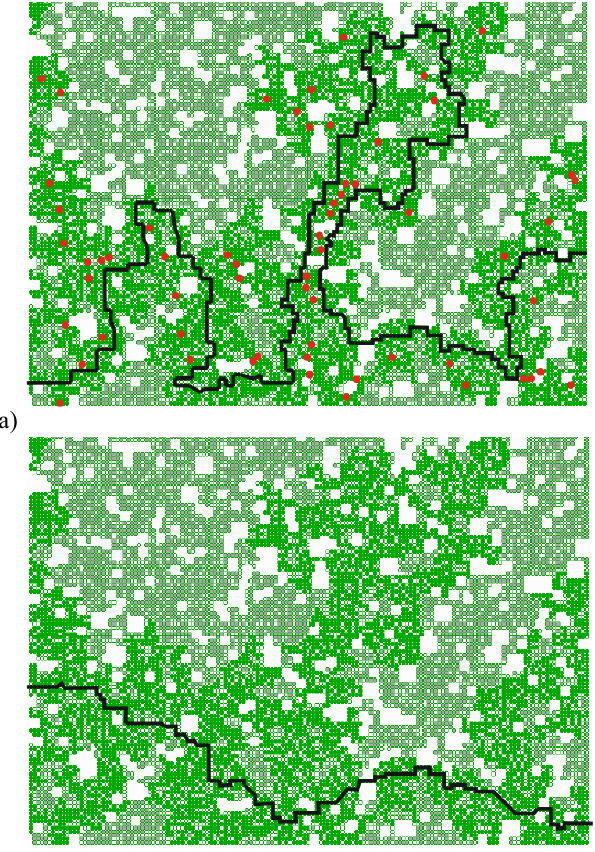
Figure 4. The path of least resistance of percolation structures to electric current